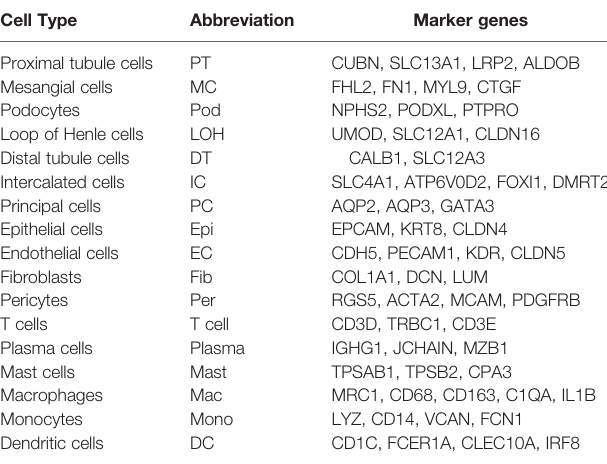
TABLE 1 | Cell-lineage-speci fi c marker genes of different kidney